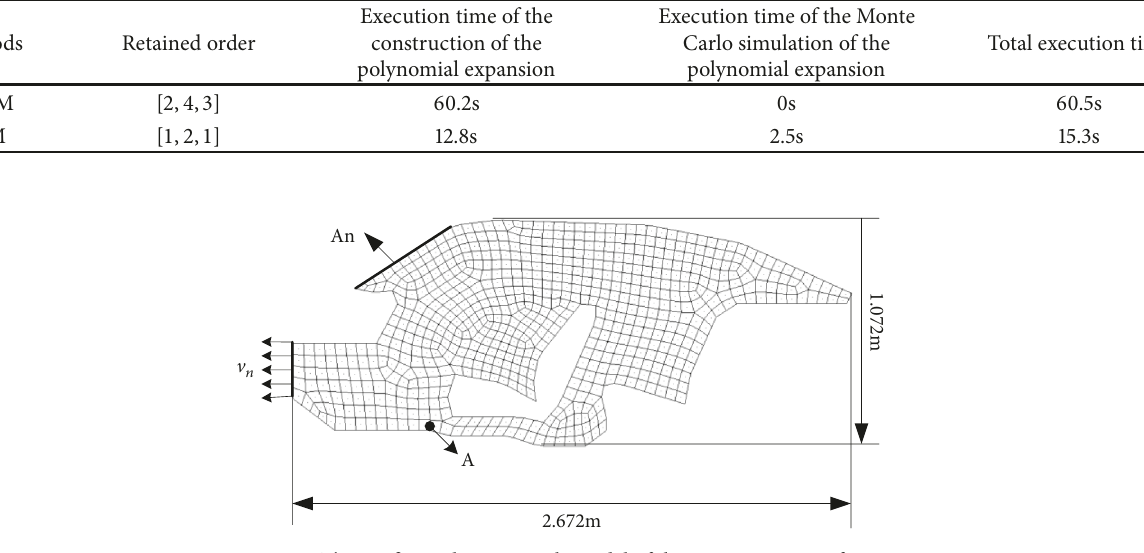
Figure 6: The 2D finite element mesh model of the acoustic cavity of a